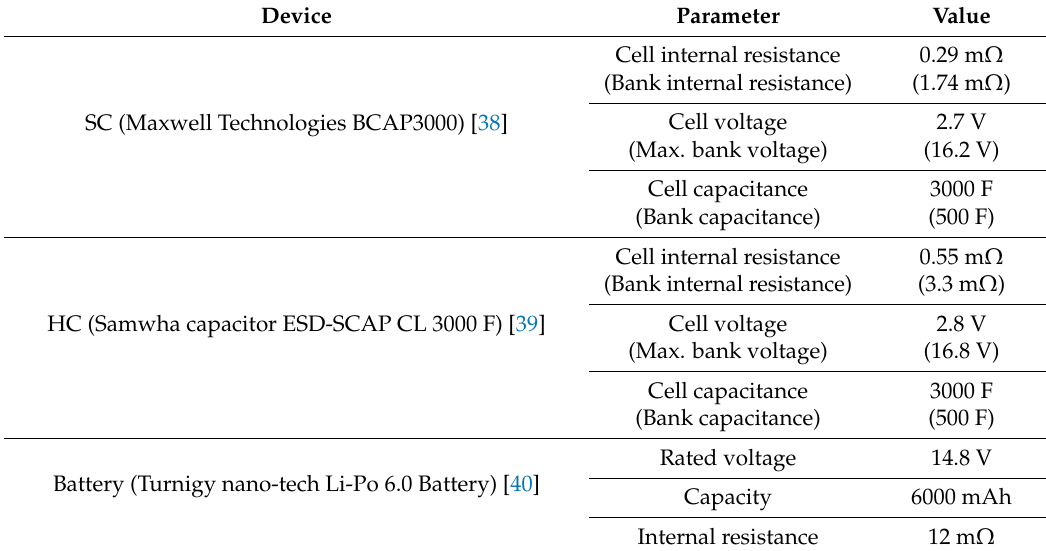
Figure 2. Comparison of the physical sizes of the supercapacitor (SC) and hybrid capacitor (HC) banks. Table 1. Electrical characteristics of the battery, SC, and HC used for the experimental implementation.